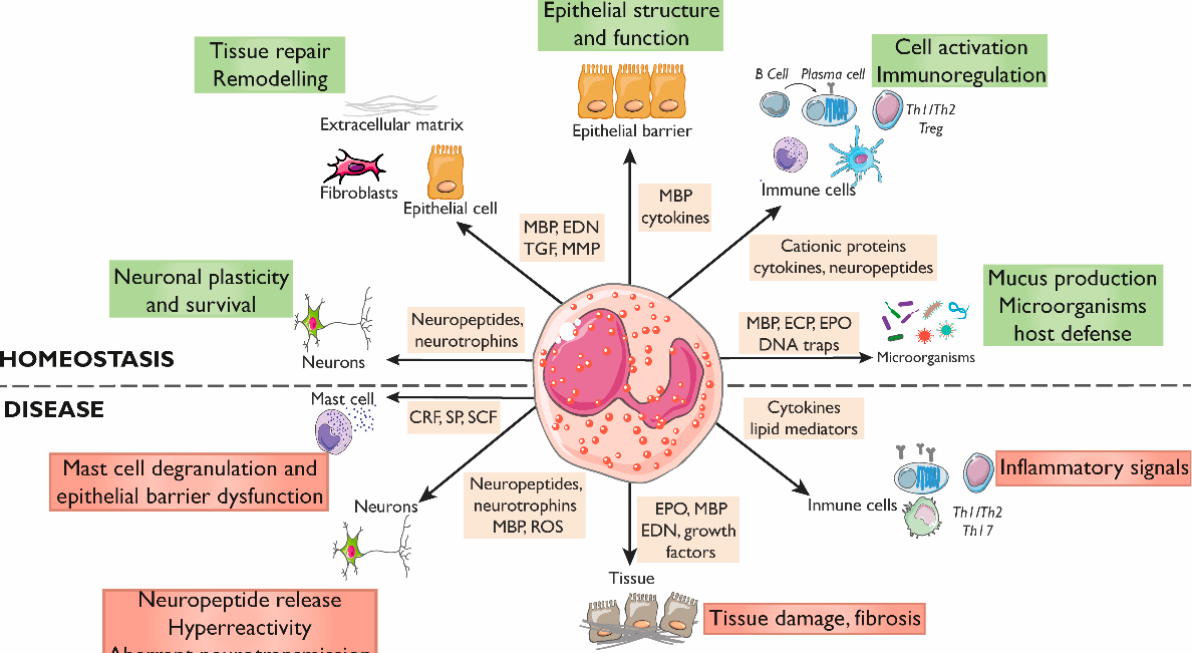
Figure 2. Roles of eosinophils in gastrointestinal homeostasis and disease. The interactions between eosinophils and other constituents of the intestinal mucosa (nerves, immune cells, endothelium, stroma, and luminal factors) mediate barrier integrity maintenance or tissue damage through the release of granule mediators. Major basic protein and eosinophil-derived cytokines contribute to barrier function through prostaglandin and ion secretion and mucus production. Eosinophils also impact tissue immuno-regulation and inflammation through cytokines and growth factors that promote adaptive and innate immunity, including a direct effect on mast cells in inflammatory or under stress conditions. Eosinophils also prime B cells for antigen-specific IgM production and sustain long-lived plasma cells. They participate in protection against infections through the release of DNA traps and the stimulation of mucus production through cationic proteins. In addition, eosinophils are also a source of a varied range of proteins and cytokines involved in fibrogenesis and angiogenesis that promote tissue remodeling, repair, and fibrosis. Eosinophils can regulate the function, survival, and development of nerve cells through the release of eosinophil-derived neuropeptides and neurotrophines, MBP, and ROS, and can promote hyperreactivity and aberrant neurotransmission in pathological conditions. CRF, Corticotropin releasing factor; ECP, Eosinophil cationic protein; EDN, Eosinophil-derived neurotoxin; EPO, Eosinophil peroxidase; MBP, Major basic protein; MMP, Matrix metalloprotease; ROS, Reactive oxygen species; SCF, Stem cell factor; SP, Substance P; TGF, Transforming growth factor.